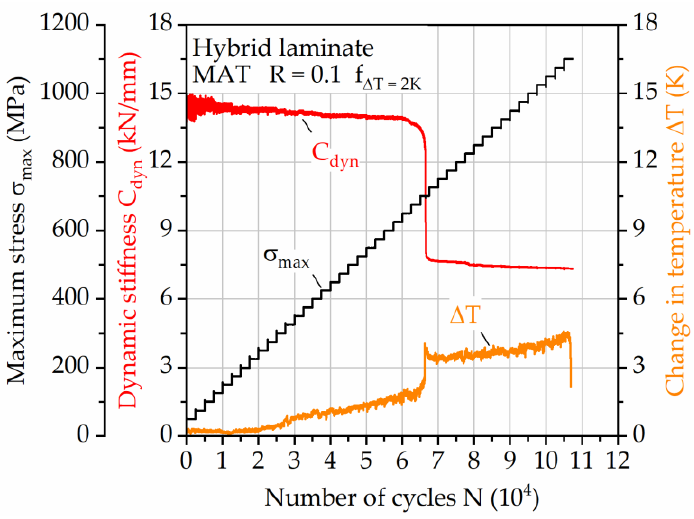
Figure 9. Load increase test for hybrid laminate in 1/2-configuration of 1.4310 and carbon fiber reinforced PA 6, showing the development of dynamic stiffness and change in temperature when testing with adjusted frequency for a change in temperature of 2 K.